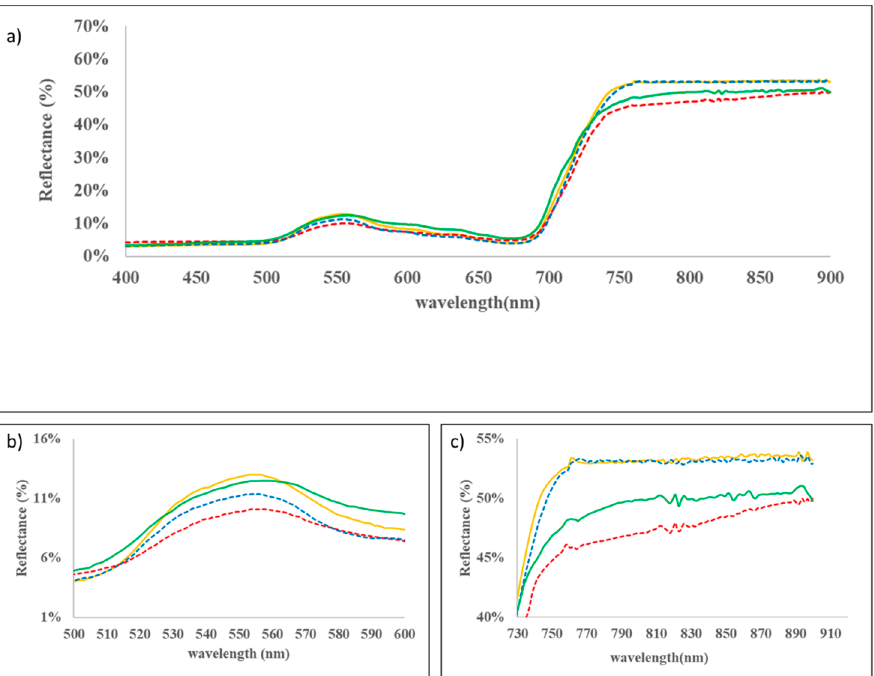
Figure 7. Leaf-level spectral reflectance curves of the four target species: Psidium cattleianum (blue), Psidium guajava (green), Luehea divaricata (red) and Hovenia dulcis (yellow) with spectral ranges at 400–900 nm ( a ); zoom in green spectral range ( b ); and zoom in NIR spectral range ( c ). Native species are represented by the dashed lines, and invasive species by the solid lines.